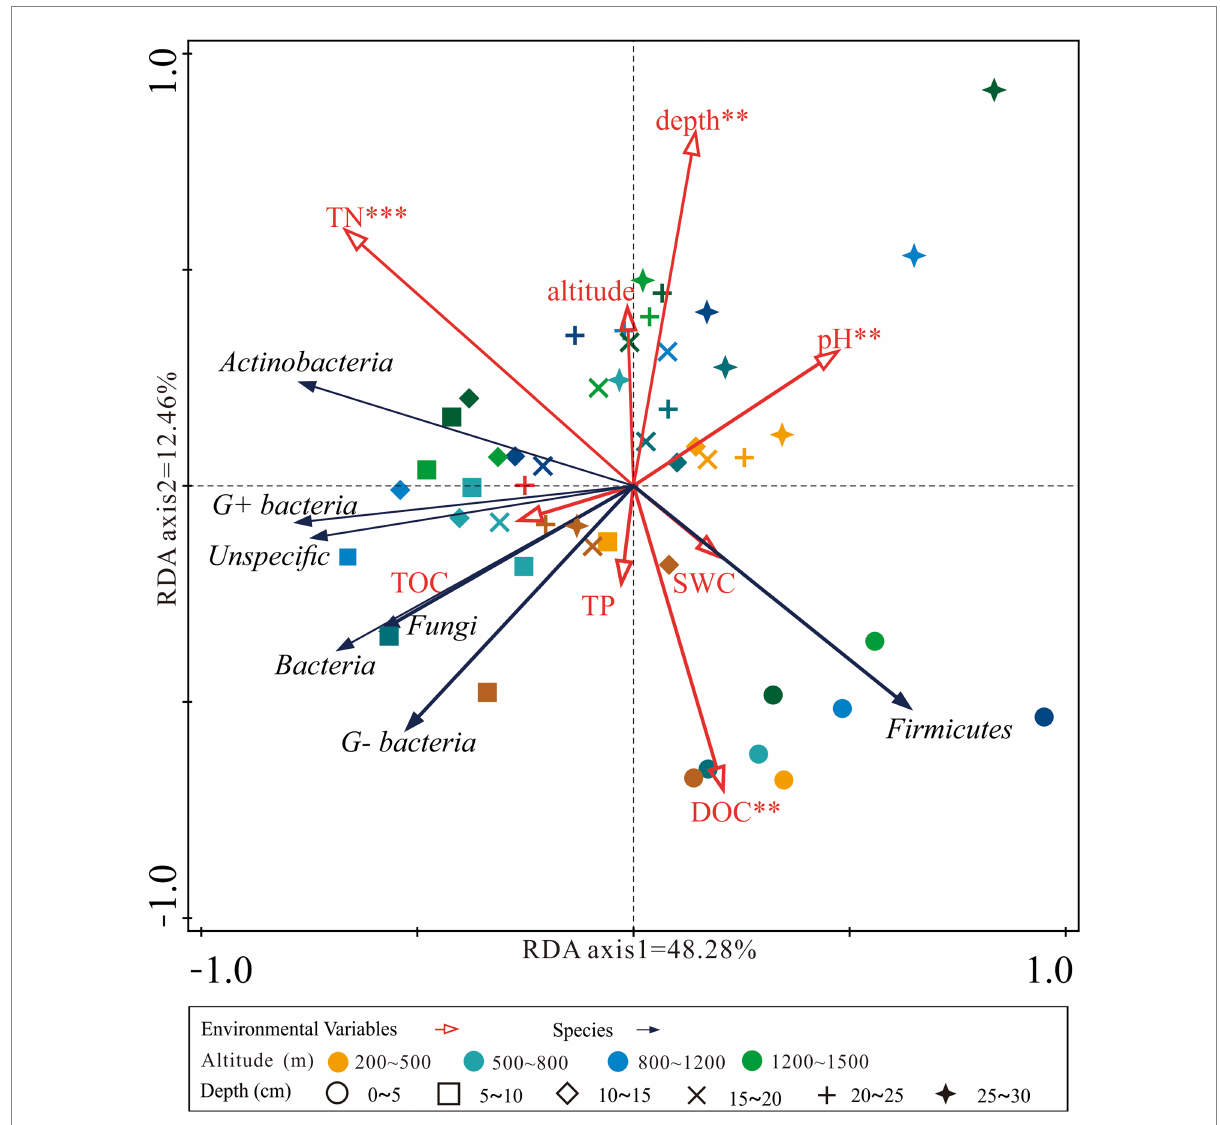
FIGURE 4 Redundancy analysis (RDA) ordination plot of the concentration of microbial groups constrained by the altitude, soil depth, and physicochemical properties. DOC, dissolved organic carbon; TOC, soil total organic carbon; TP, total phosphorus; TN, total nitrogen; SWC, soil water